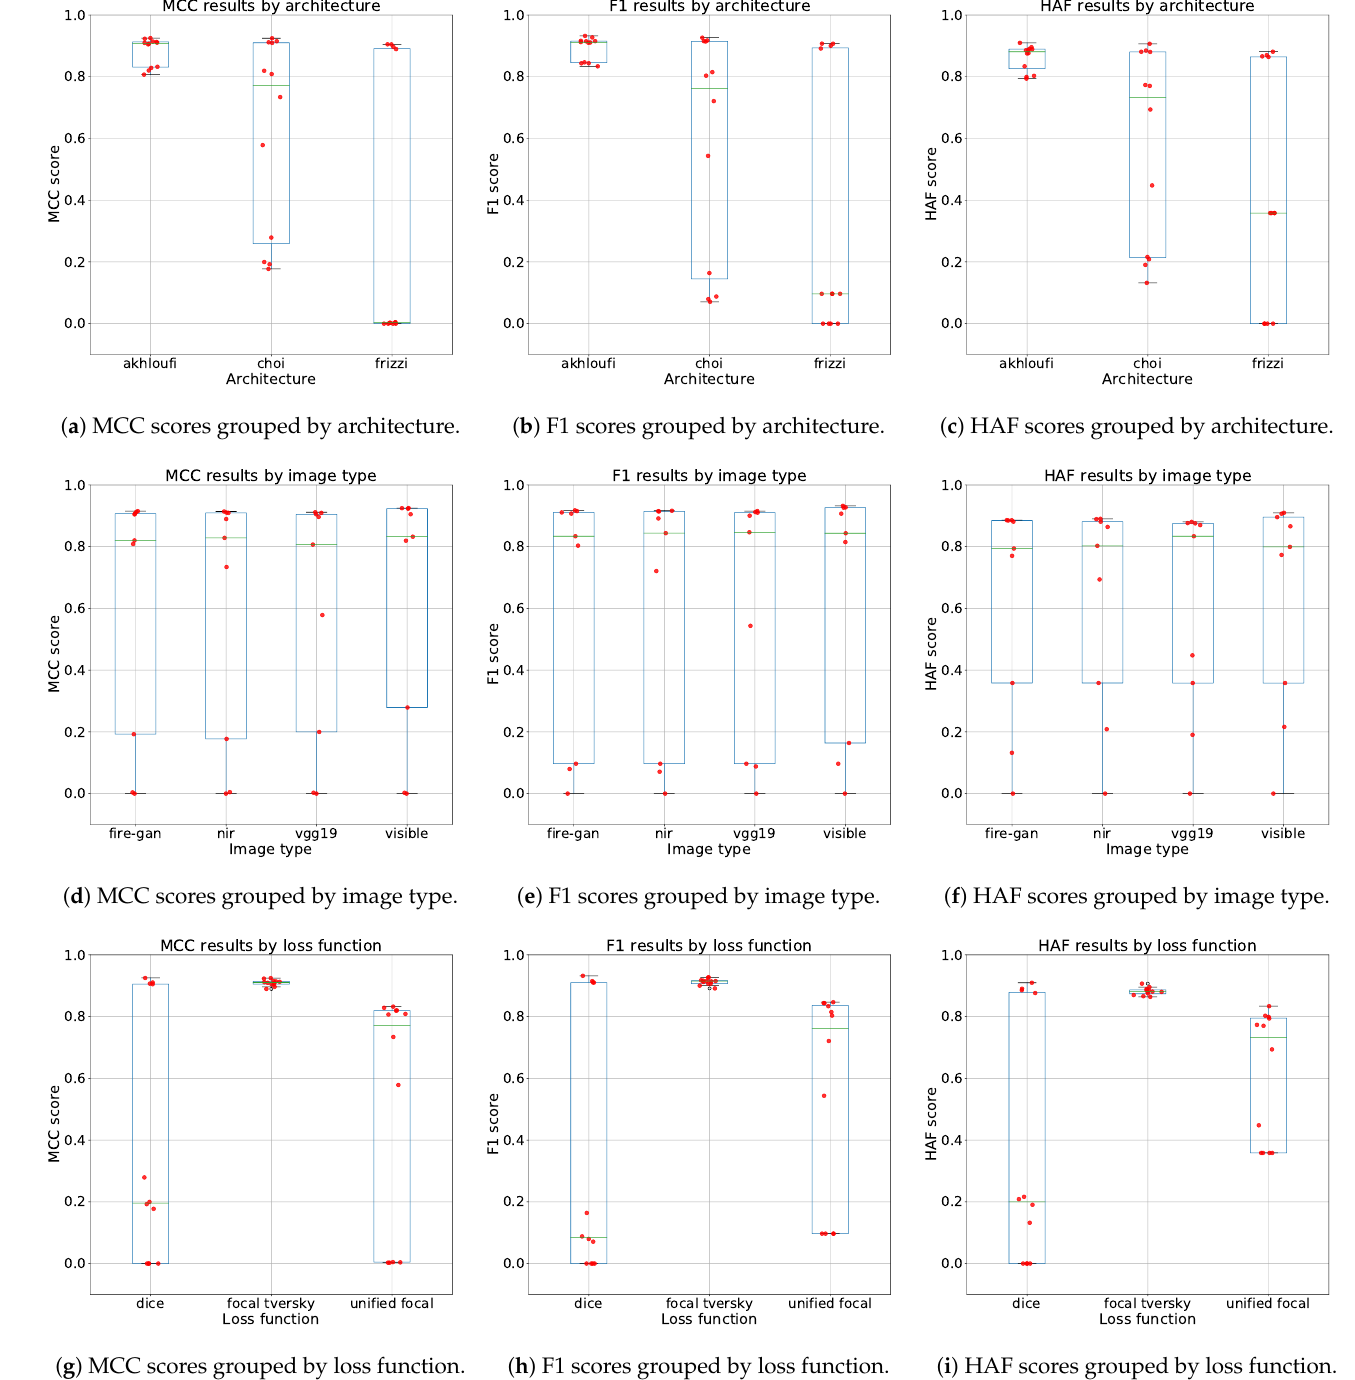
Figure 16. Results grouped by architecture (first row), image type (second row), and loss function (third row) for all metrics. We can observe that the Akhloufi architecture and the Focal Tversky loss show by far the most robust results, displaying high and consistent scores across all metrics. In contrast, the image type appears to have very little influence on the segmentation performance, as the results are considerably similar for all image types, with only a slight advantage for the visible images on the MCC and F1 metrics. In Figure 17, we can see the resulting segmentation masks for the Akhloufi + Focal Tversky combination for all image types to visually assess the similarity in the